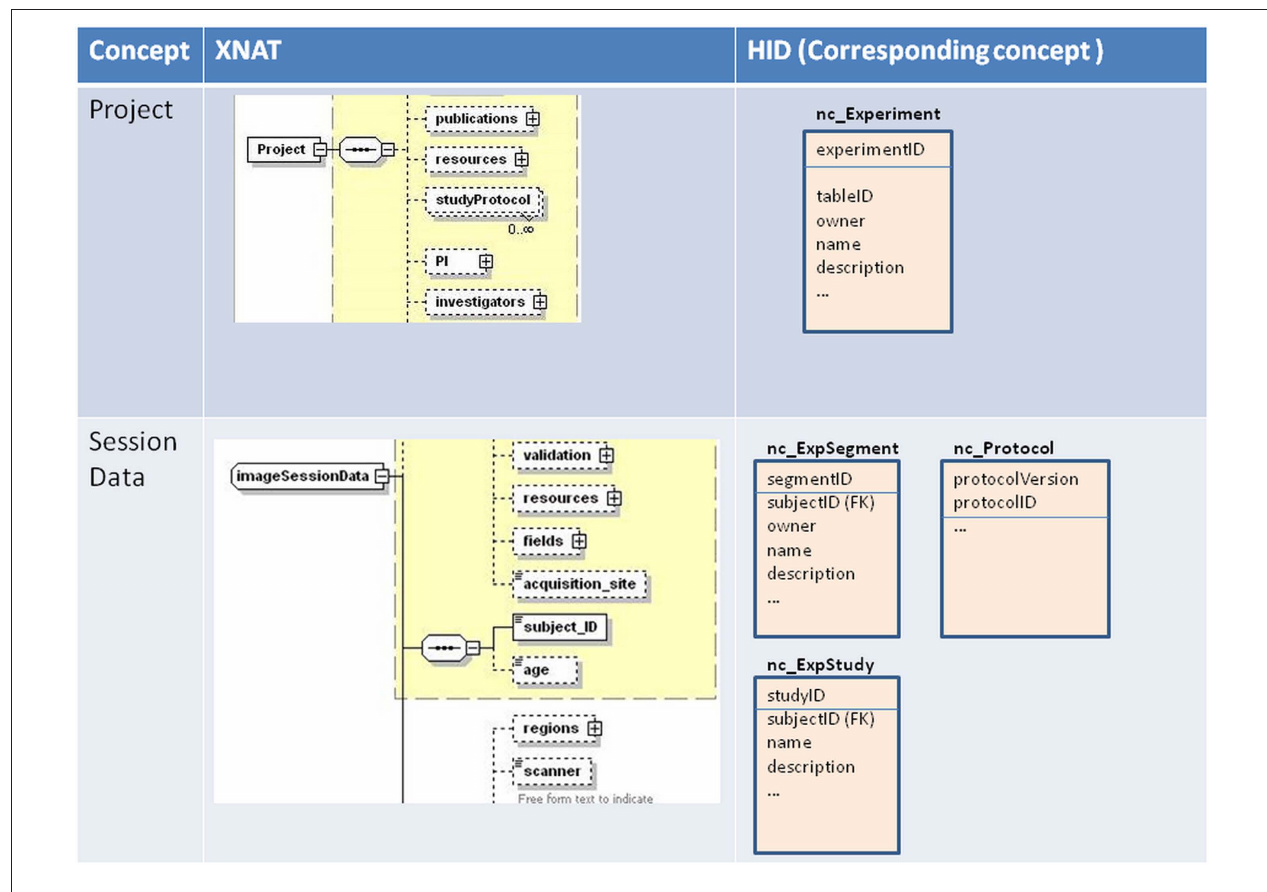
Figure 4 | (Model) Heterogeneity Across HiD and